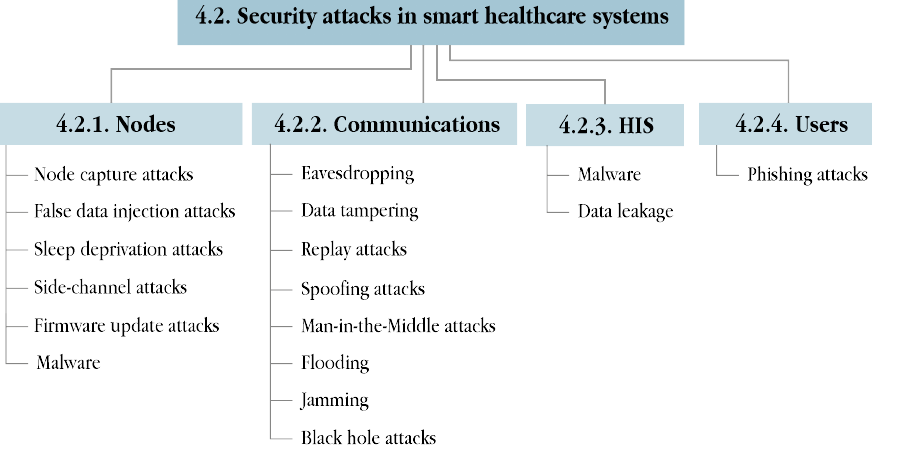
Figure 5. The taxonomy of security attacks in smart healthcare